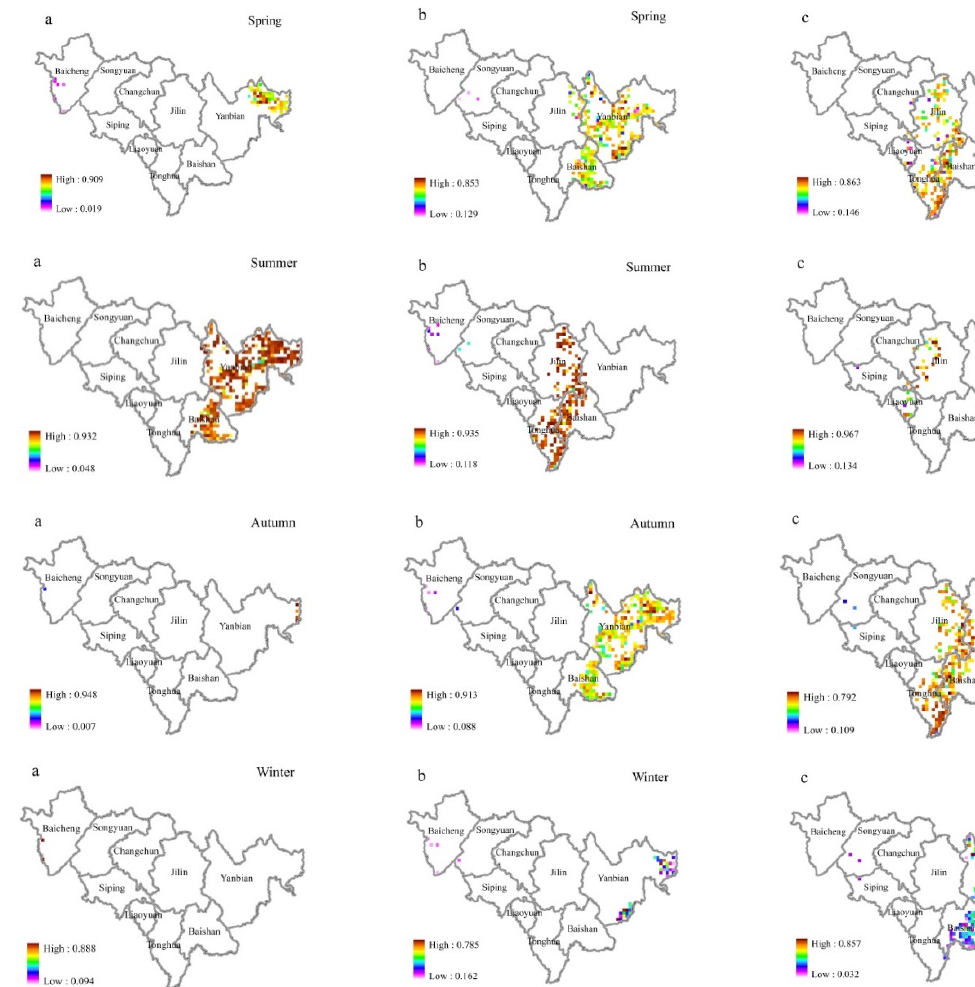
Figure 8. Broadleaf tree resistance to SO 2 stress in different seasons. The figure parts ( a – e ) represent the ρ (SO 2 ) class. The affiliation values of different ρ (SO 2 ) levels of resistance in the same season (( a ). very low, ( b ). low, ( c ). moderate, ( d ). high, ( e ). very high) are shown horizontally, and the affiliation values of the same ρ (SO 2 ) level of resistance in different seasons are shown vertically.